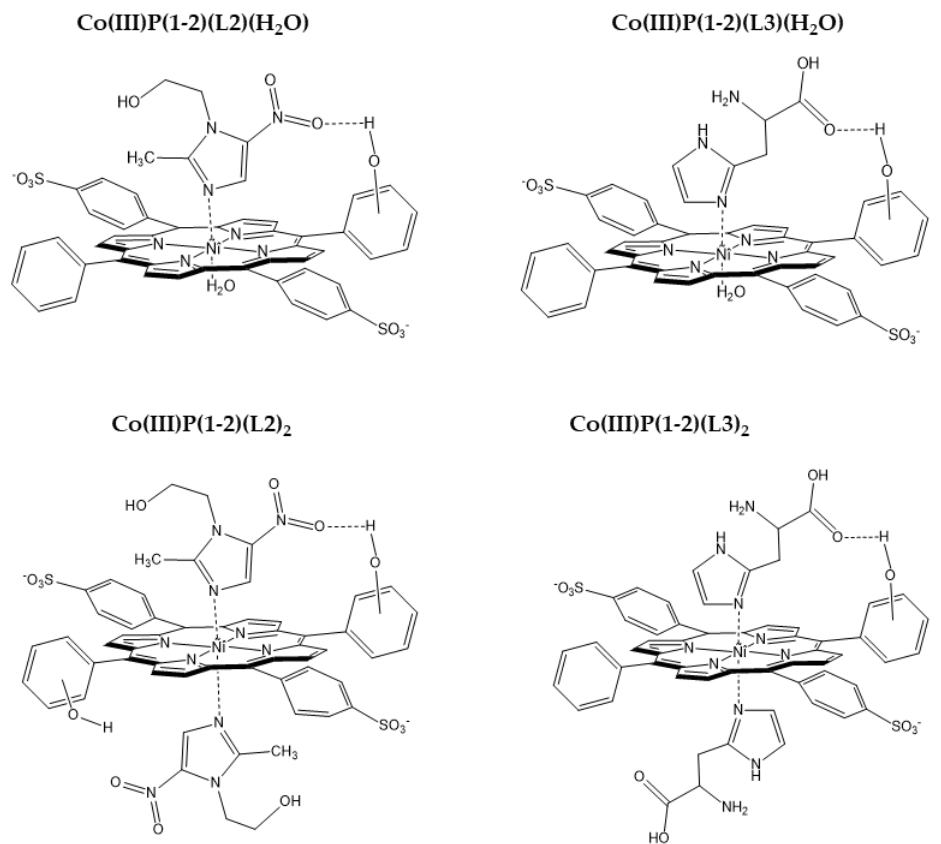
Figure 14. Structures of the complexes Со(III)P(1-2)(L2)(H 2 O), Со(III)P(1-2)(L3)(H 2 O), Со(III)P(1-2)(L2) 2 , and Со(III)P(1-2)(L3) 2.